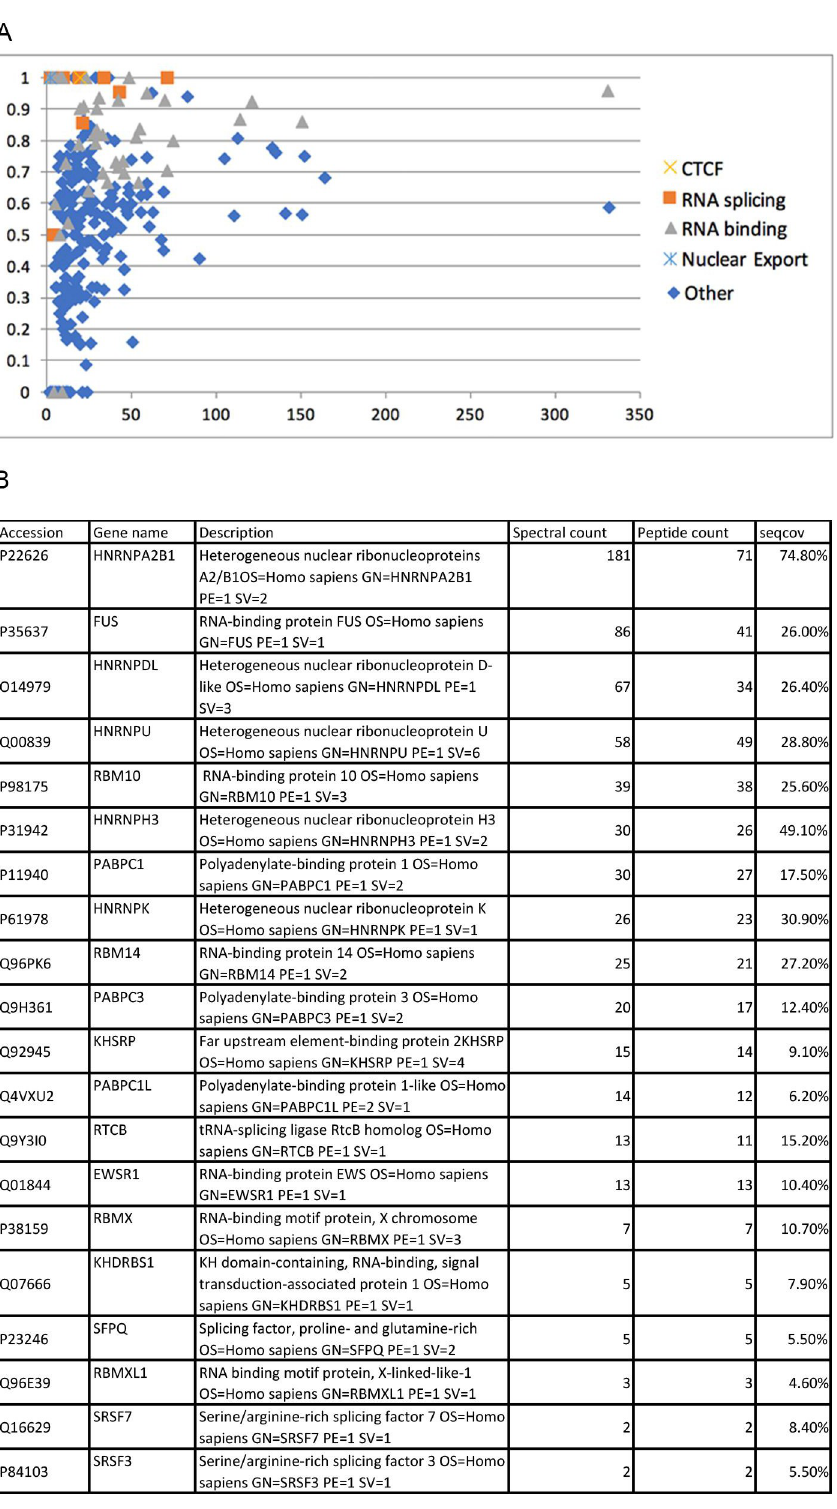
PLOS Genetics | https://doi.org/10.1371/journal.pgen.1009277 January7,